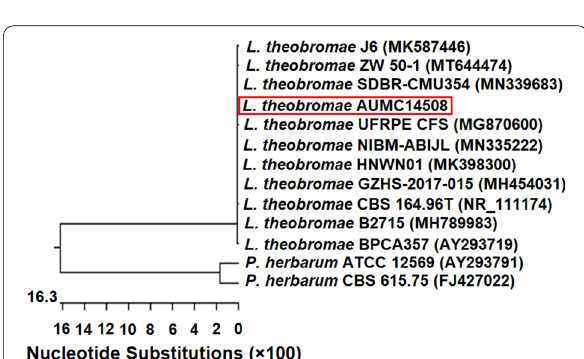
Fig. 3 Phylogenetic tree of the fungal isolate L. theobromae AUMC14508 and other closely related strains, based on the ITS15.8 S rRNAITS2 rDNA